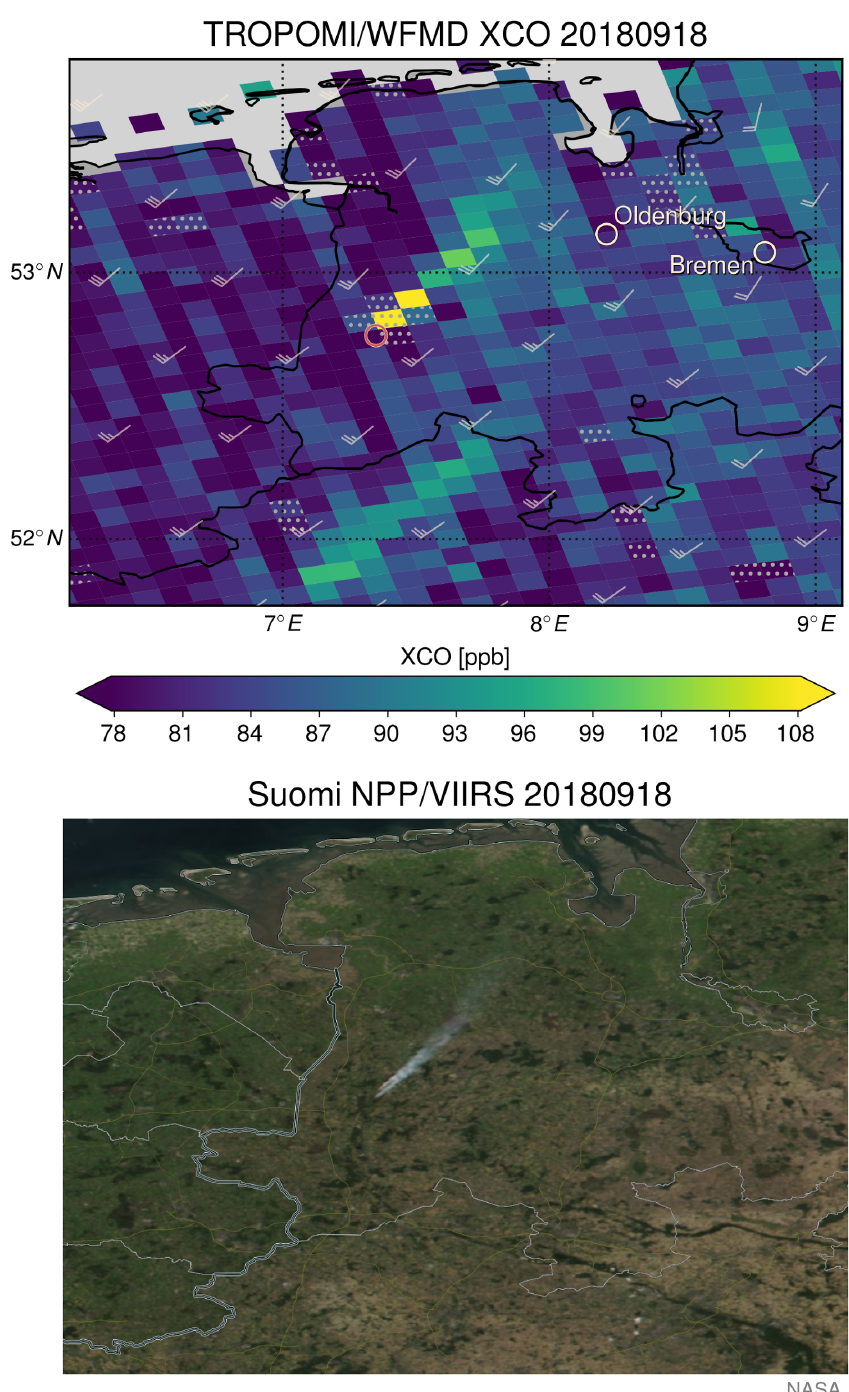
Figure 21. Carbon monoxide enhancement due to the peat fire (red circle) in the Emsland region in Germany. Dotted scenes are excluded by the quality filter. Also shown is the boundary layer wind from the ECMWF. The bottom panel shows the corresponding true colour reflectances from the Visible Infrared Imaging Radiometer Suite